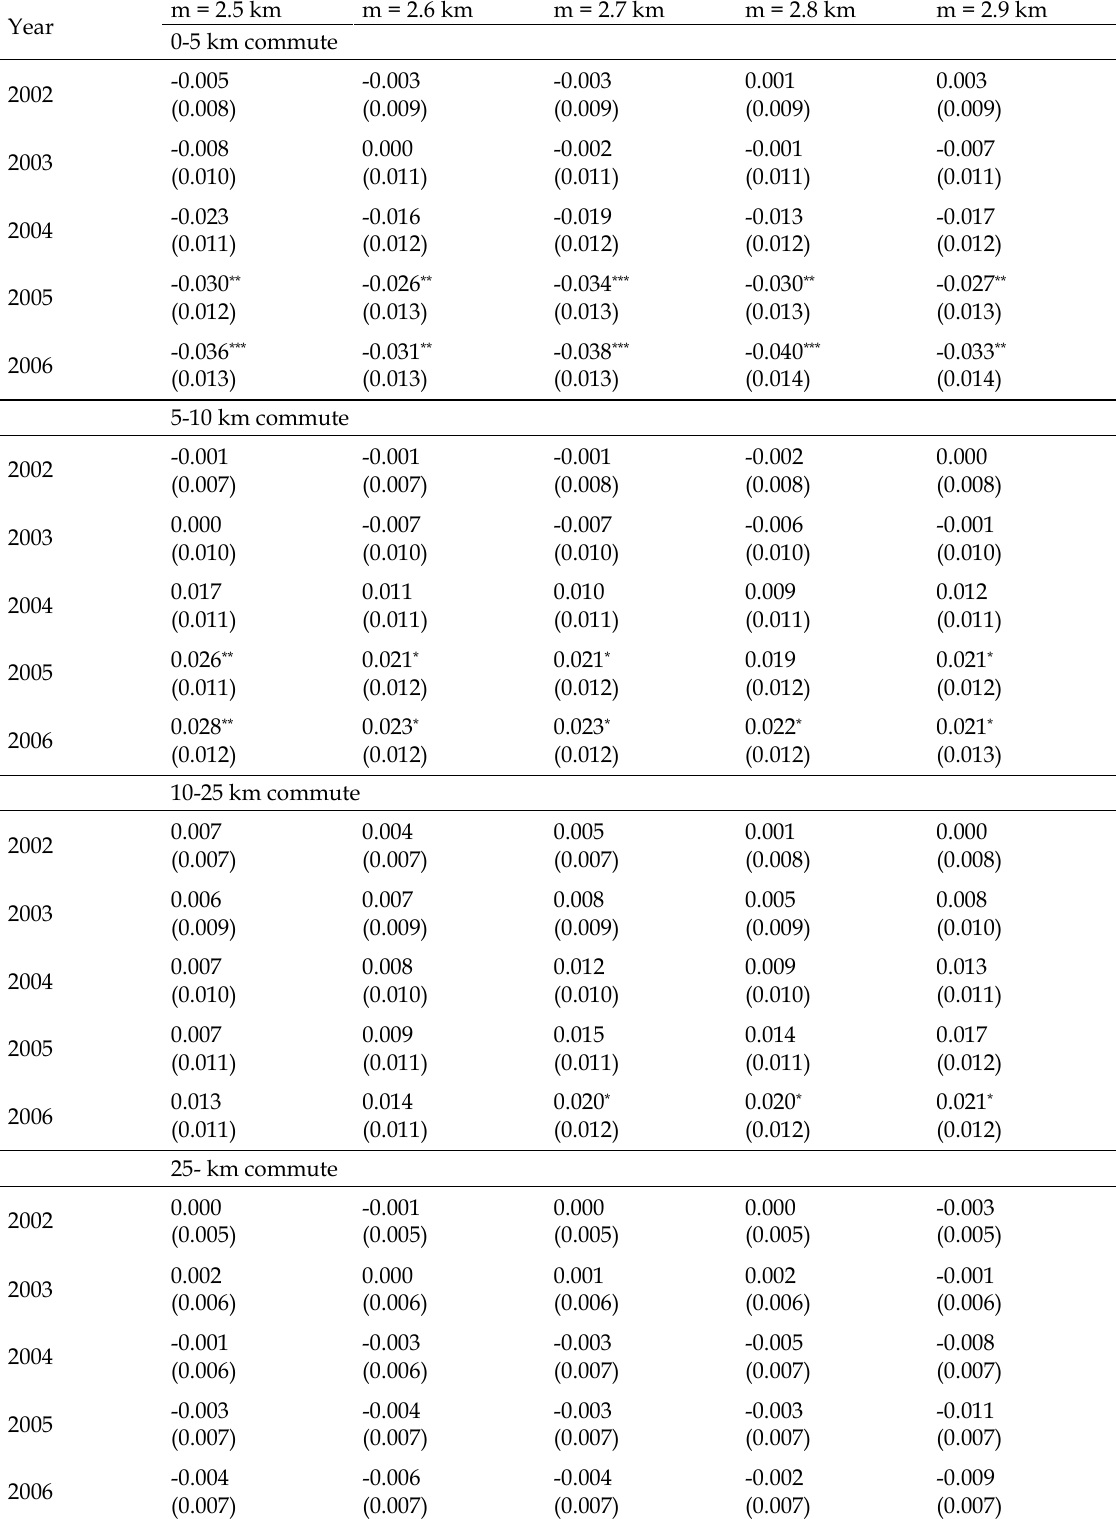
Table 5. Estimated post-treatment effect of improved access on area-commuting